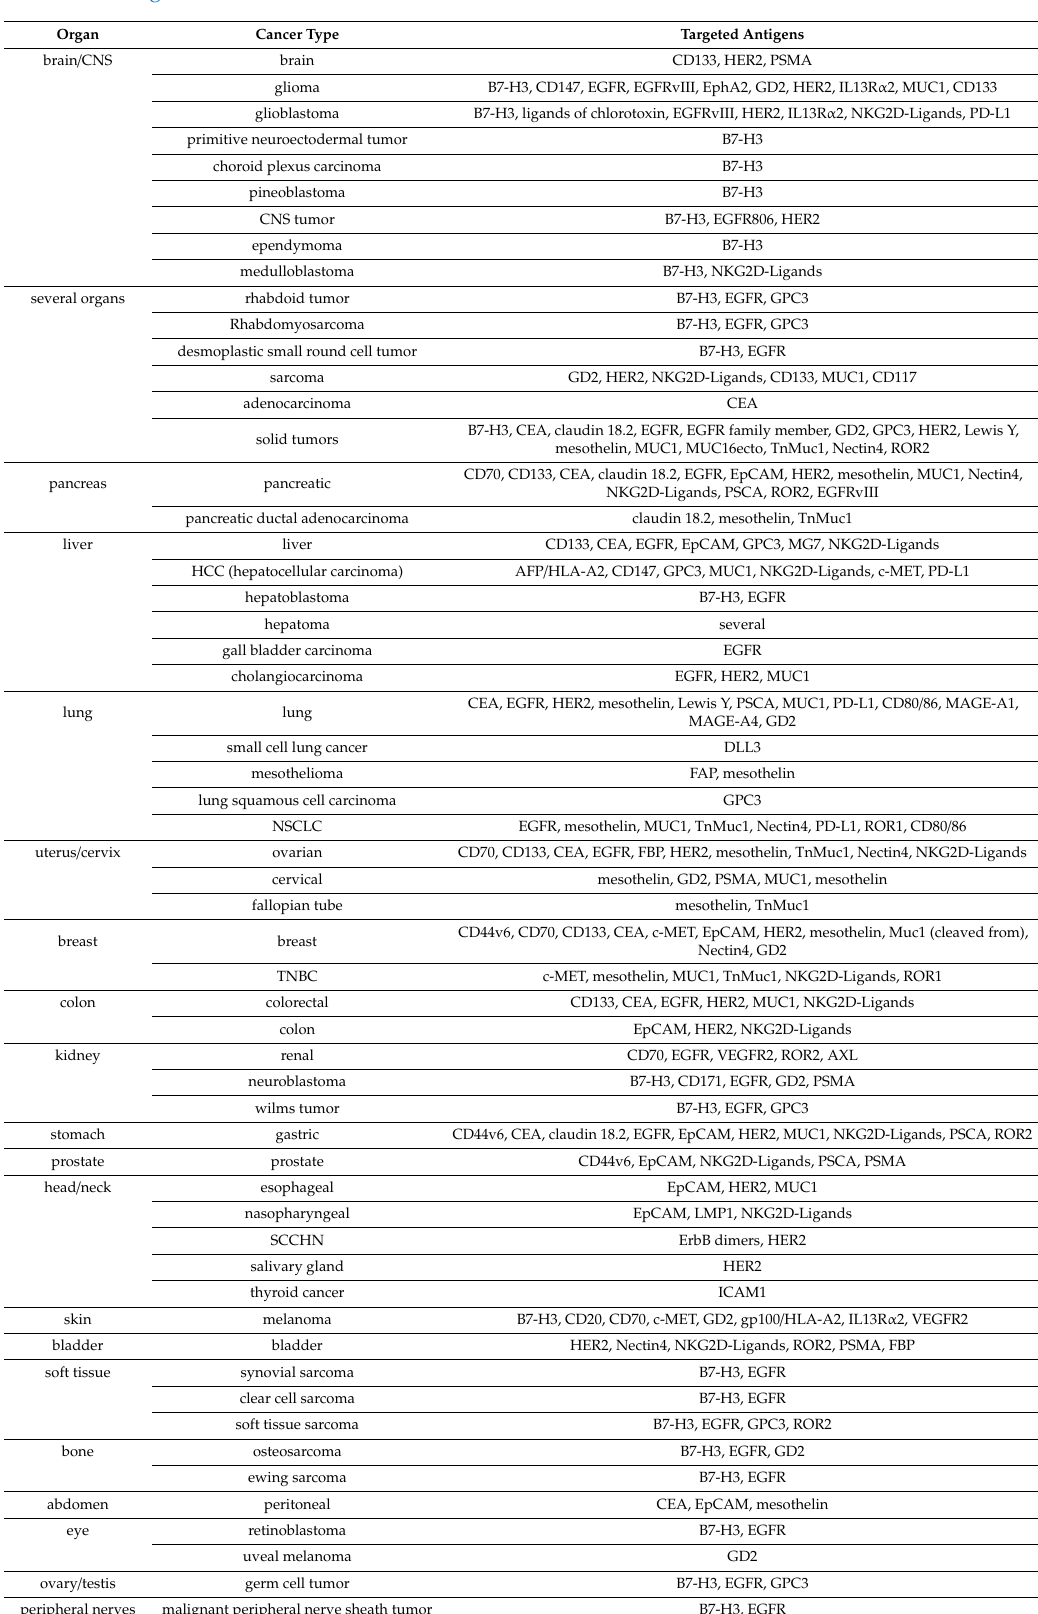
Table 2. Summary of antigens targeted on di ff erent tumors by CAR-T cells in trials registered at